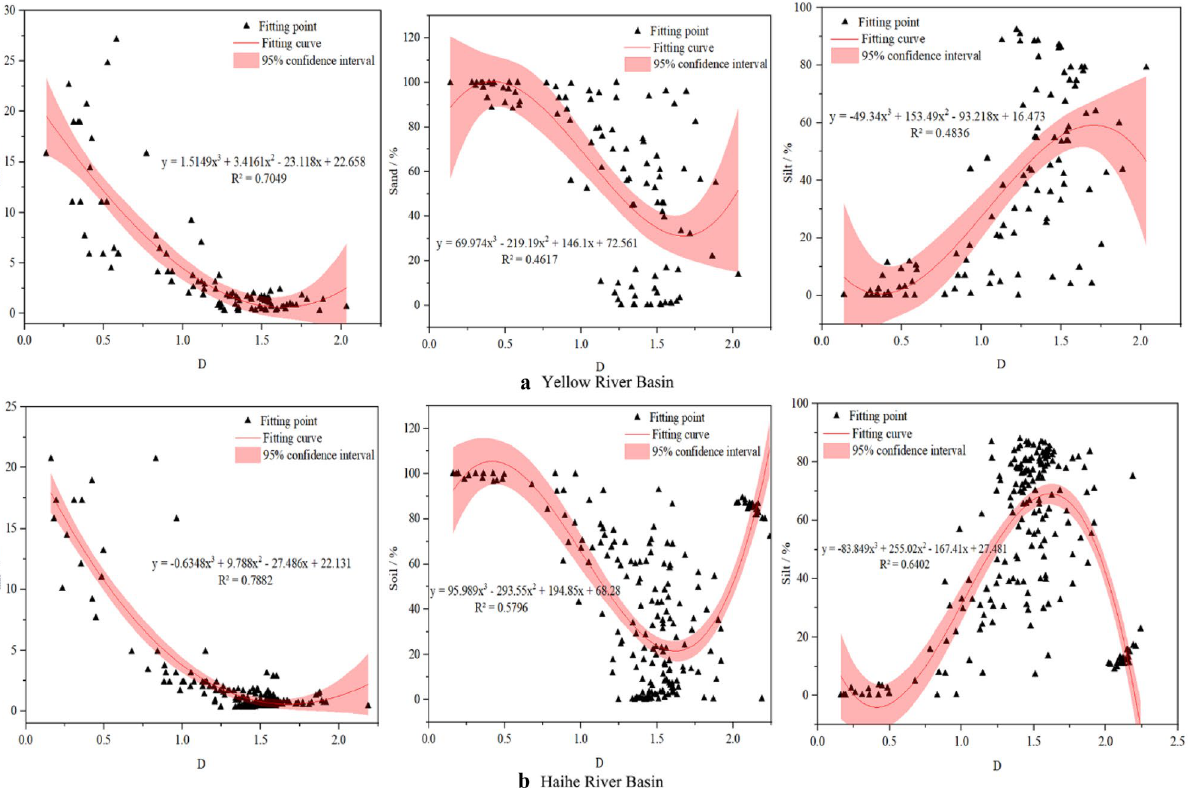
Figure 7. Fitting curves of D with d min , sand content, and silt content for individual